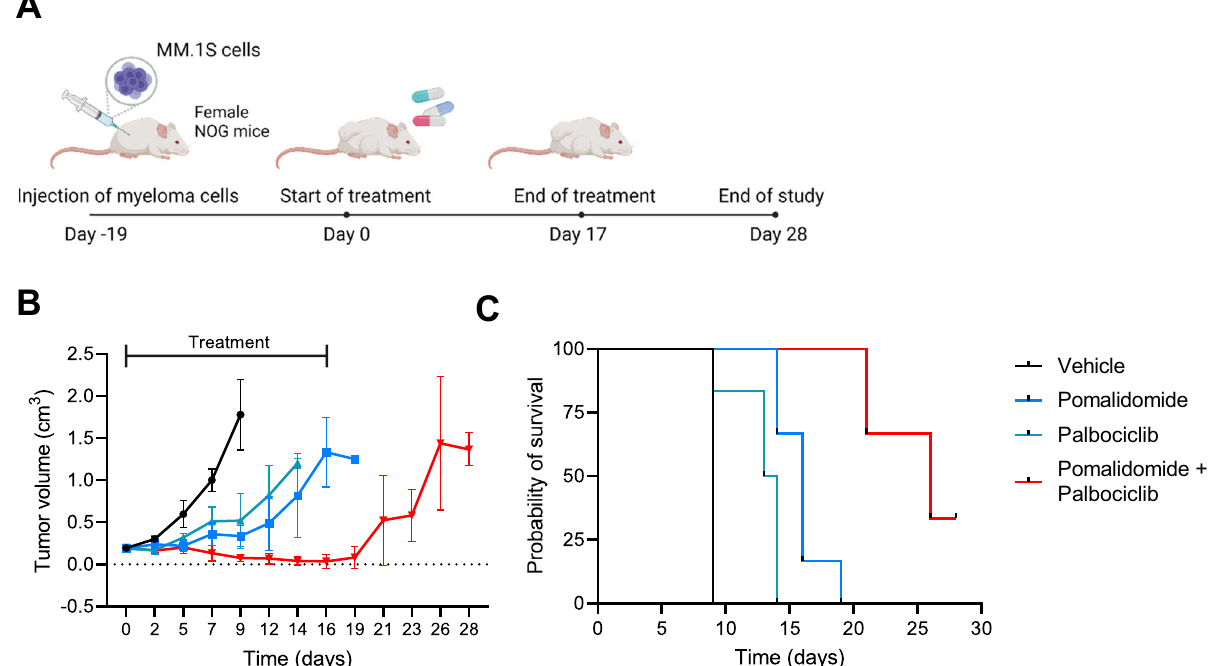
Fig. 5 Combination treatment of pomalidomide and palbociclib has high therapeutic ef fi cacy in multiple myeloma in vivo. A MM.1S cells were injected into NOG mice and treatment started 19 days after injection of myeloma cells when tumors were ~0.2 cm 3 . Mice were treated on a daily basis with vehicle control, pomalidomide (5 mg/kg), palbociclib (50 mg/kg) or the combination p.o. for 17 days and observed until day 28. B Tumor growth in treated mice of monotherapy of pomalidomide and palbociclib, and in combination. Mice were taken out of the study when tumors exceeded a size of 1.2 cm 3 . C Survival of the four groups. Statistical differences were analyzed by log-rank Mantel – Cox test. All comparisons of survival curves resulted in P -vaues < 0.01. Data represent mean ± SD of biological replicates. Group size: n = 5 for vehicle group; n = 6 for pomalidomide treatment group; n = 6 for palbociclib treatment group; n = 6 for pomalidomide + palbociclib treatment group. Figure A was created with BioRender.com. Source data are provided as a Source Data fi